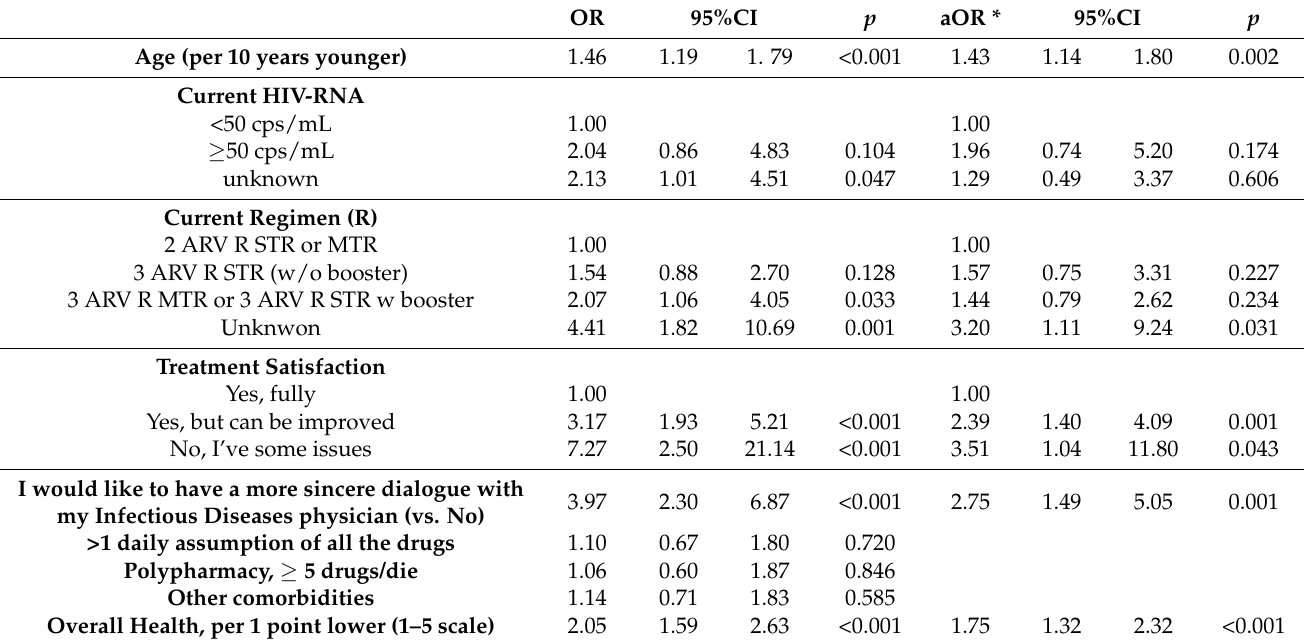
Table 2. Factors associated with high HIV treatment and disease burden (H-TDB).